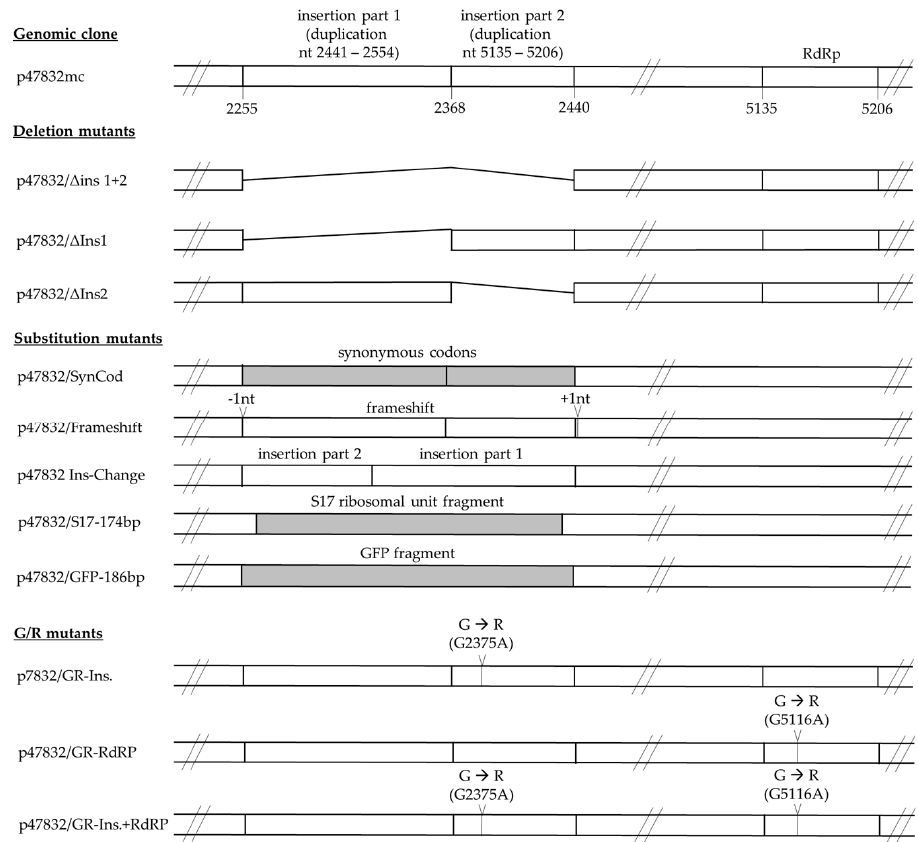
Figure 1. Schematic presentation of the generated constructs containing deletions or substitutions in the insertion of HEV strain 47832c. The original insertion is composed of two adjacent duplications from different regions of the HEV genome. The indicated numbers refer to the nucleotide positions of the genome of strain 47832c (GenBank acc.-no. KC618403.1). RdRp—RNA-dependent RNA polymerase, GFP—green fluorescent protein, S17 human ribosomal protein S17. Details of the constructs are described in the Text and in the Supplementary Table